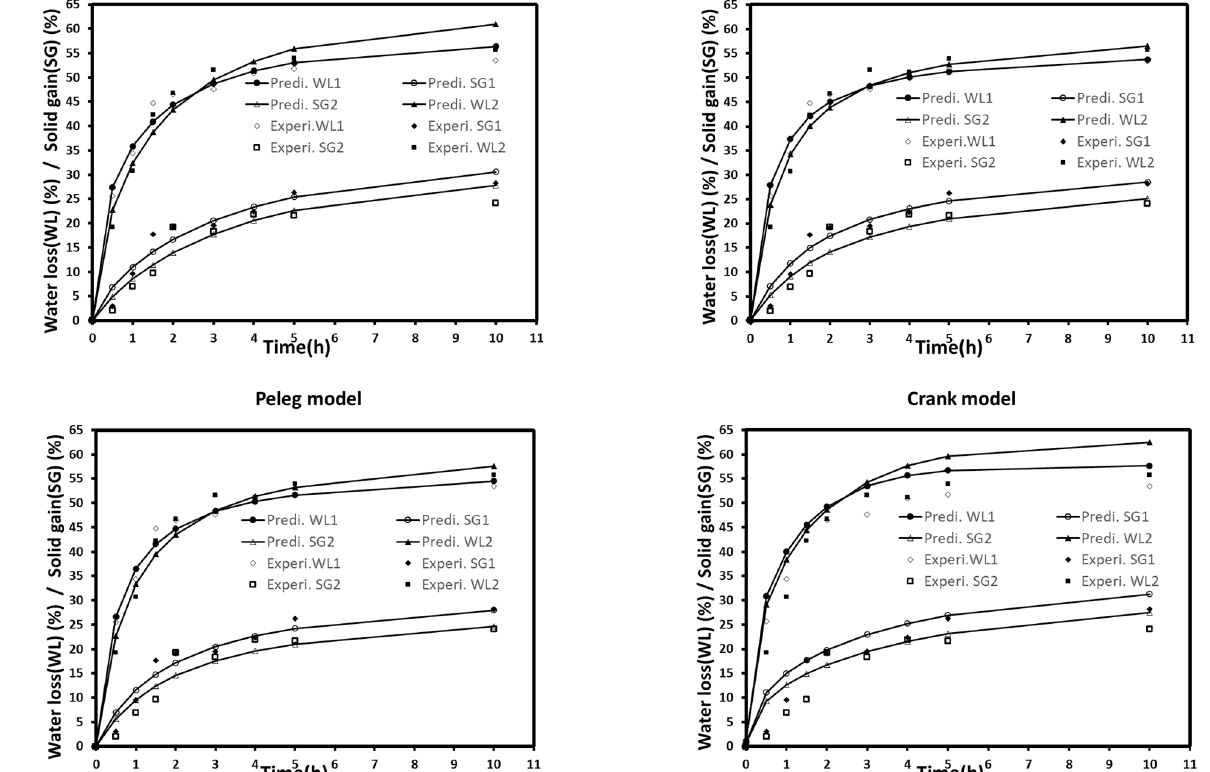
Figure 3. Experimental data and predicted models’ lines (Peleg, Azuara, Page, and Crank model) of water loss (WL) and sugar gain (SG) at atmospheric (1) and vacuum (2) pressures. Each point represents the mean of a duplicate of three repetitions.